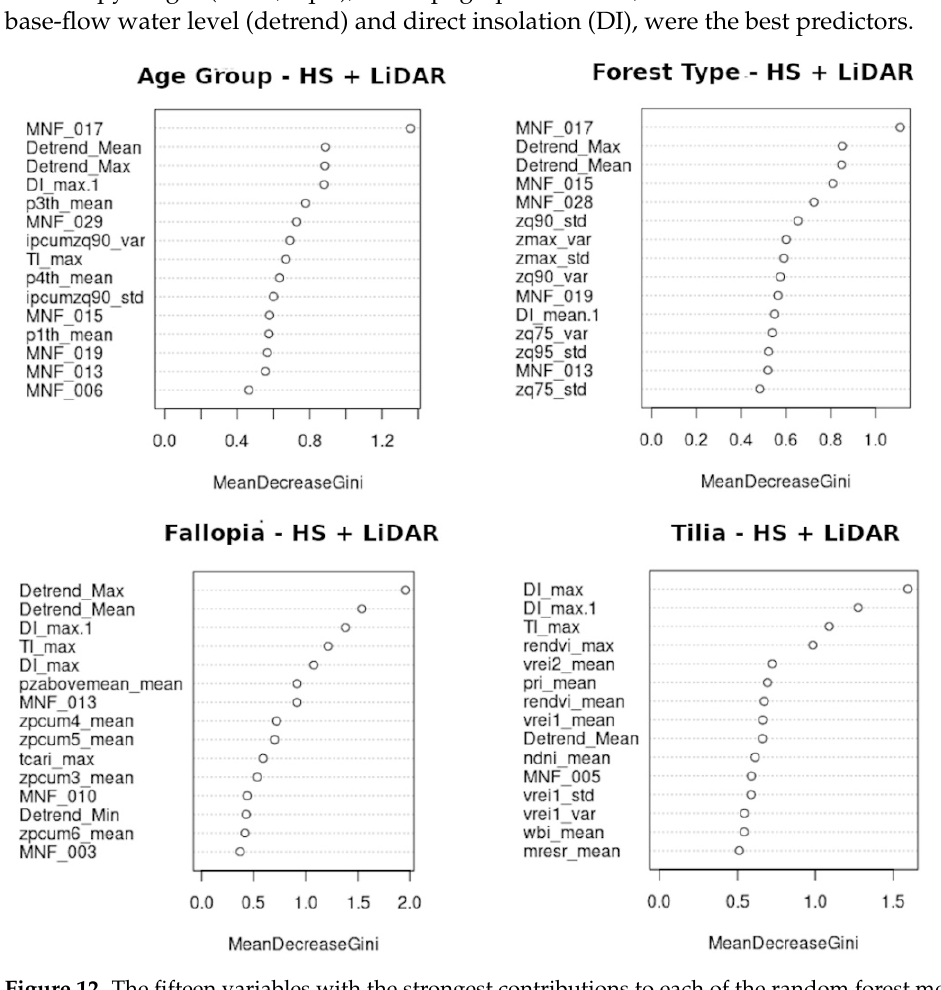
Figure 12. The fifteen variables with the strongest contributions to each of the random forest models when combining both LiDAR and hyperspectral data, ordered by mean decrease in gini.